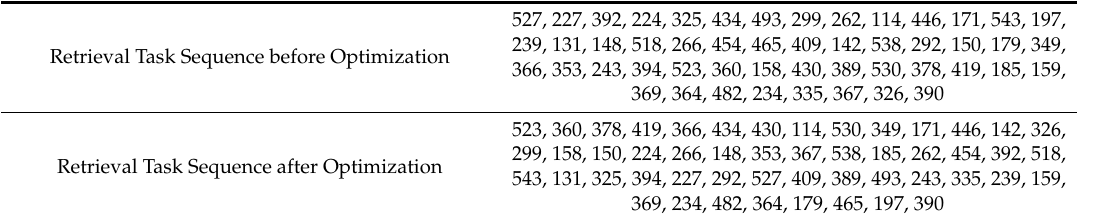
Table A3. shows the list of retrieval tasks before and after optimization when Task = 100. Before optimization, the retrieval operation time is 752.1 s; after optimization, the retrieval operation time is 647.6 s. The retrieval operation e ffi ciency improved